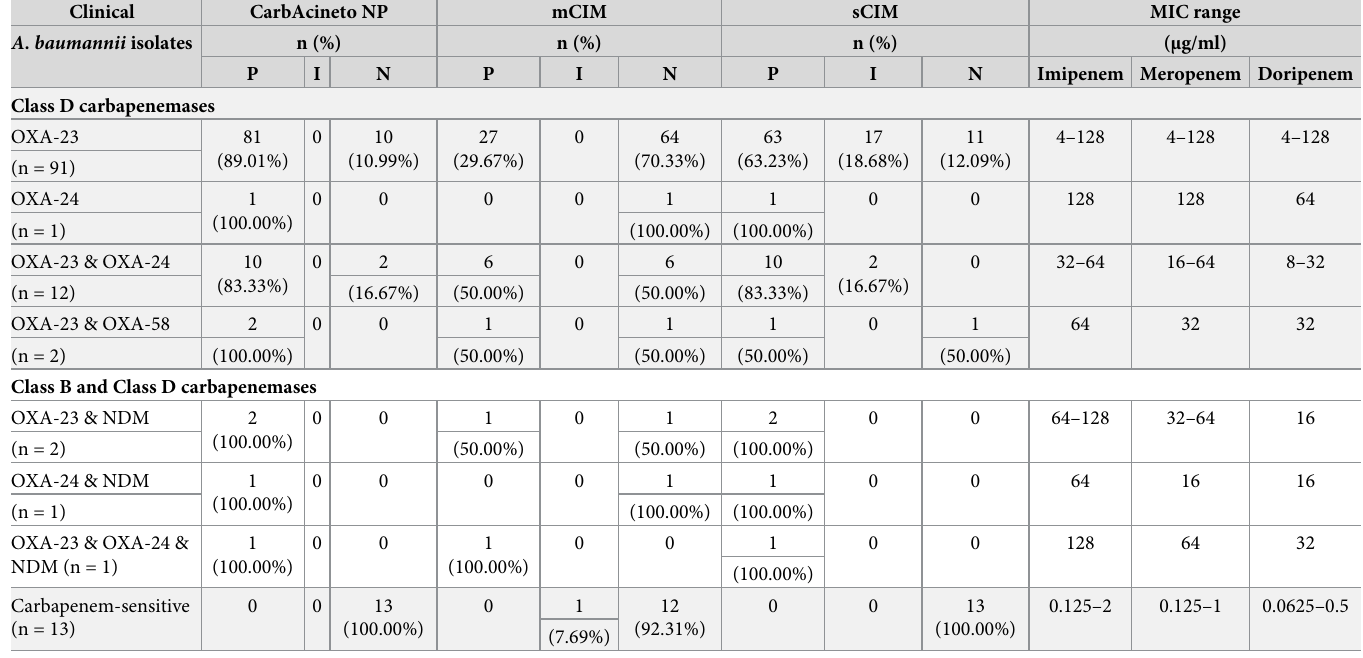
Table 2. Performance of phenotypic detection methods according to genotypic characterization for A . baumannii .